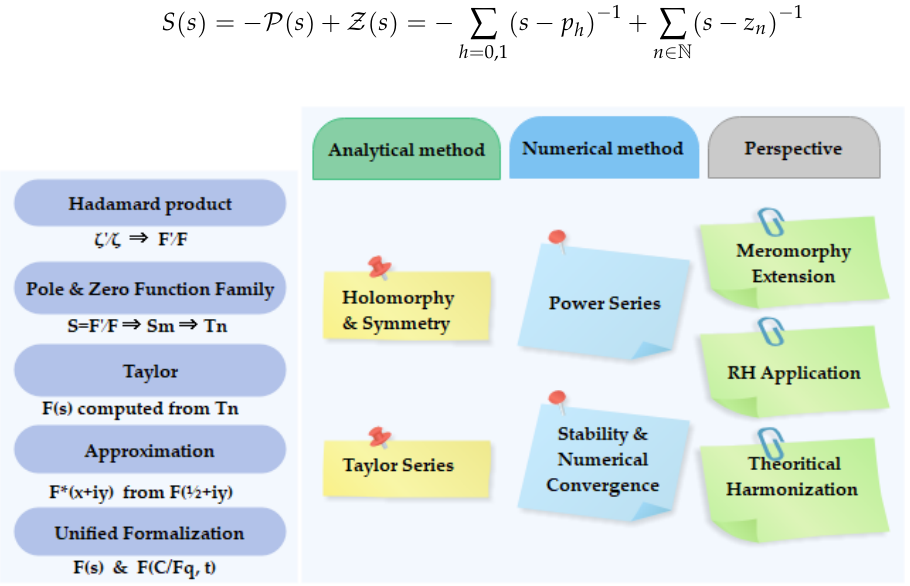
Figure 16. Milestones of the article from both the analytical and numerical methods. Apart from the subset K of trivial zeros z k = − 2 k ; k ∈ N , the N non-trivial zeros z n of the ζ function belong to the CL L and potentially to the CS S\L . It is necessary, in any calculations, to separate the two disjoint subsets Z and Z of the N = P + Q non-trivial zeros. It is unknown whether the number Q of possible zeros in the CS, excluding the CL, is zero, finite, or